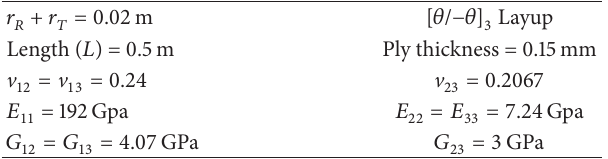
Table 2: Shear stress effects on the first natural frequency ( Ω